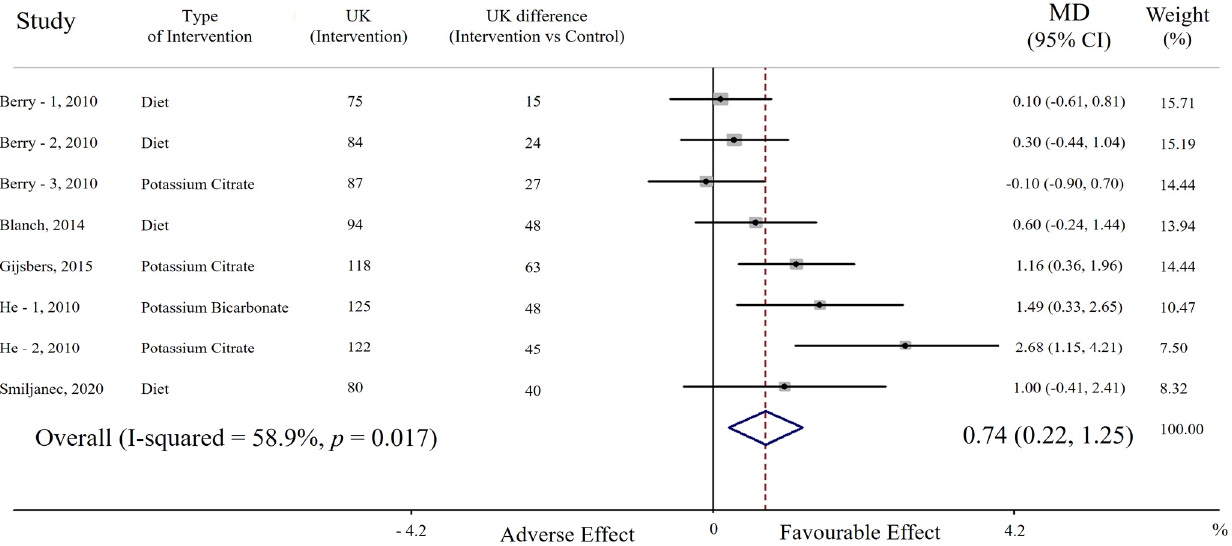
Figure 1. Forest plot of the effect of potassium supplementation on flow-mediated dilation (FMD). Results are expressed as mean difference (MD) and 95% confidence intervals (95% CI). Squares indicate study-specific relative risk estimates (size of the square reflects the study-specific statistical weight); horizontal lines indicate 95% CI; diamond indicates the overall relative risk with its 95% CI. UK: urinary potassium excretion (mmol/24